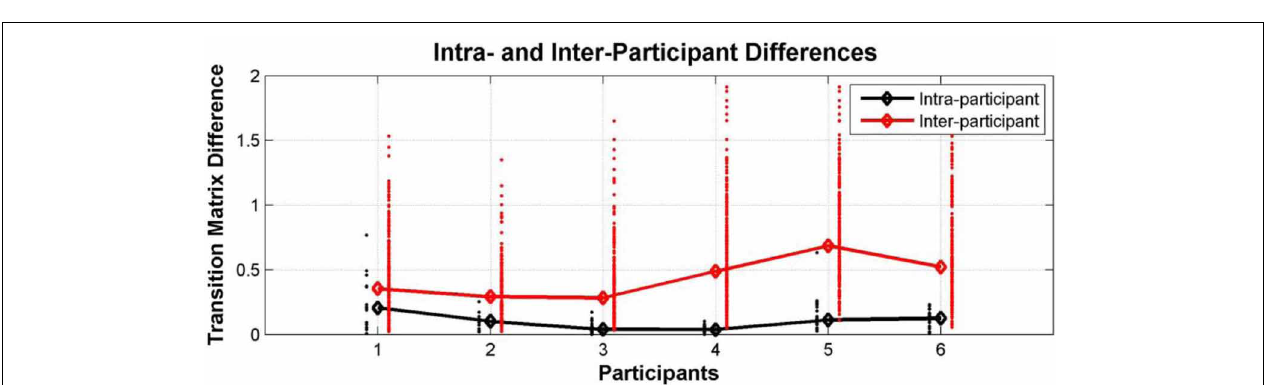
the proportion of latencies of the pattern indicated by the color code (see legend) less than the latency indicated along the x axis. For example, at a latency of 100s, less than 20% of first reports of A--- have occurred, while more than 90% of first ABA- reports have occurred.